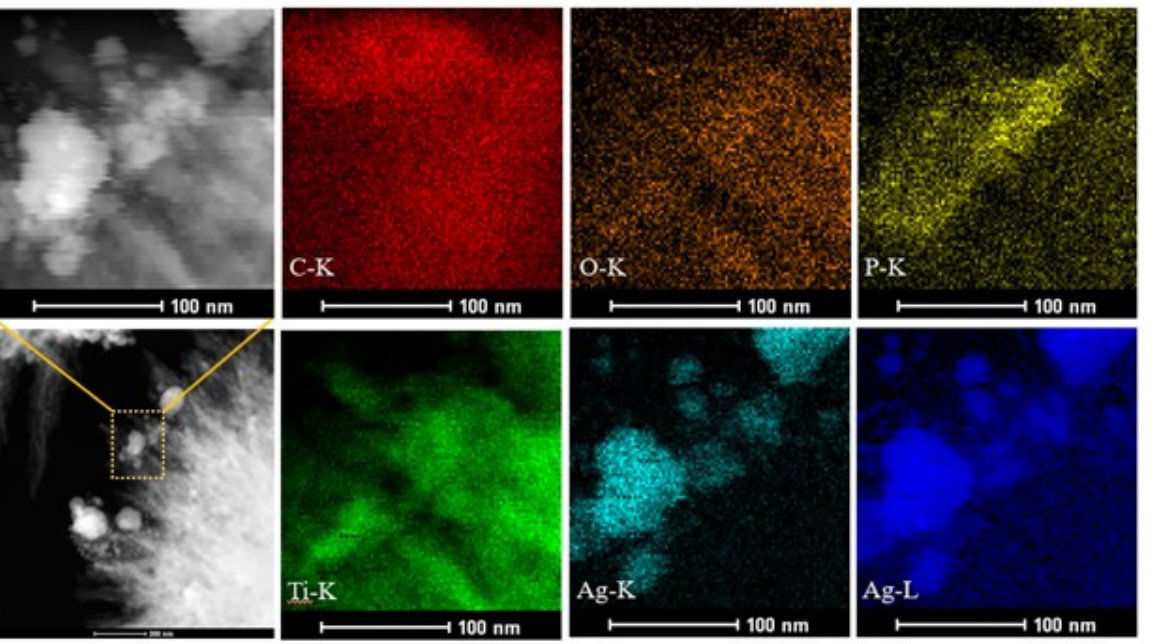
Figure 4. STEM images of Ag 3 PO 4 /TiO 2 @Ti 3 C 2 (sample A4) with element mapping (C, O, P, Ti, and